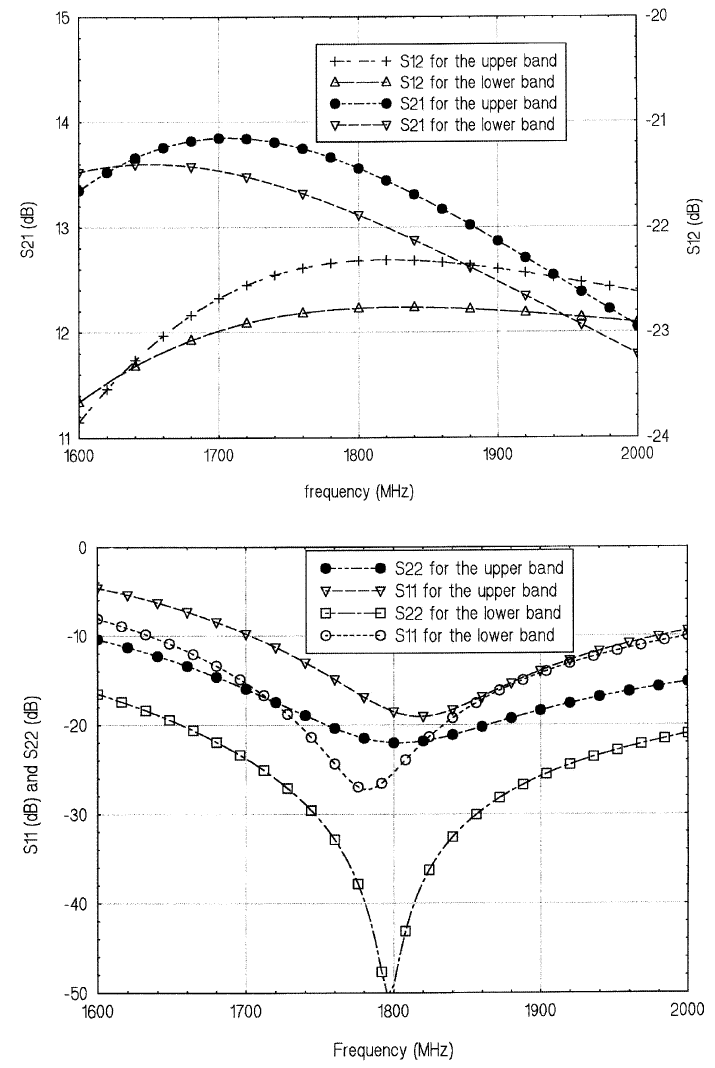
FIGURE 7 Scattering parameters for laid-out tunable